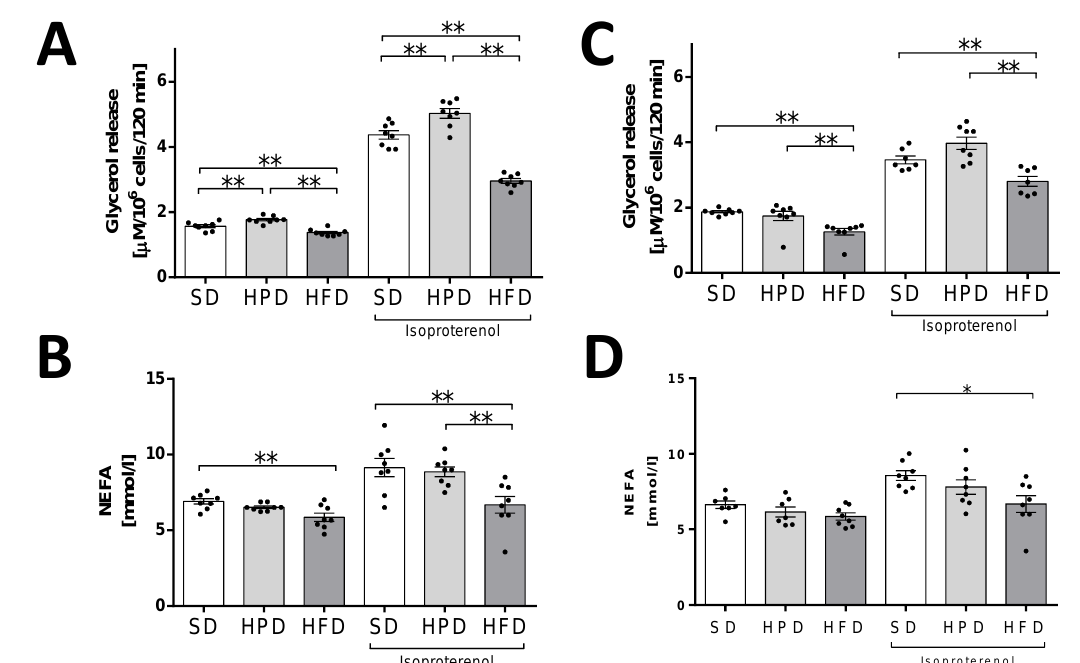
Figure 5. The effects of the standard diet, HFD, and HPD on basal and isoproterenol stimulated lipolysis in isolated rat adipocytes after 60 ( A , B ) and 120 ( C , D ) days. Intensity of lipolysis was measured as glycerol and NEFA release from cells into incubation medium. Results are means ± SEM for n = 8; significant differences between means for control and experimental groups are marked for p < 0.05 (*) and p < 0.01 (**).